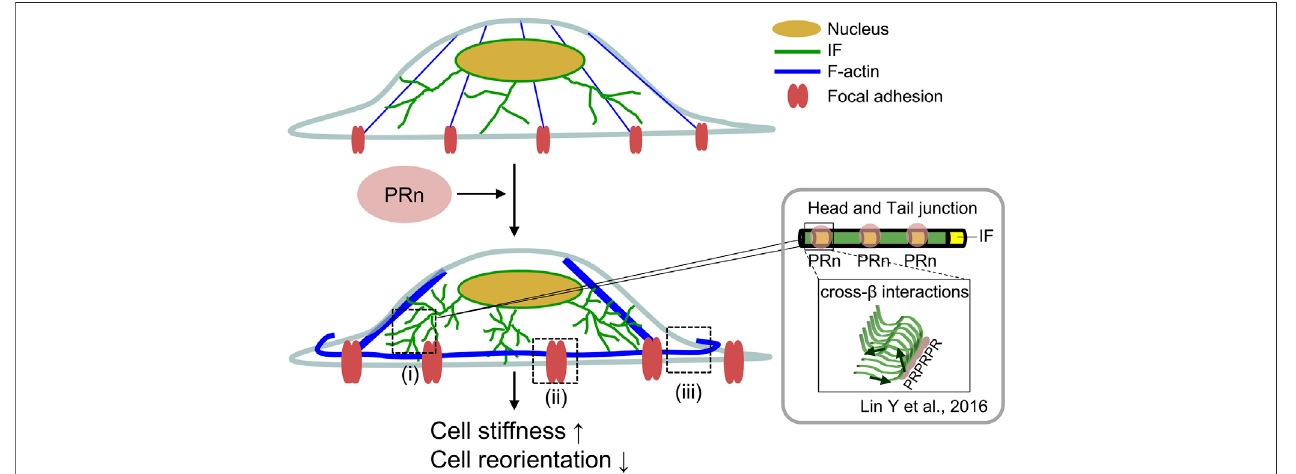
FIGURE7| Graphicalabstract. PRpoly-dipeptides bindtoIF head domain and inducedthe alterations ofcellular mechanics.PR poly-dipeptides (pink) bind tothe IFheaddomain(yellow)anddysregulatetheIFdynamics.ThisresultsinanincreaseofIFbranchesandIFmeshnetwork(green)( ⅰ ).TheIFnetworkincreasesthesizeofFA (red)( ⅱ )andthicknessofF-actinstress fi bers(blue)( ⅲ ),leadingtocellstiffness.Further,thealterationsofcytoskeletonandFAdisruptcellreorientationaftercyclicstretch. IF: intermediate fi lament, PRn: PR